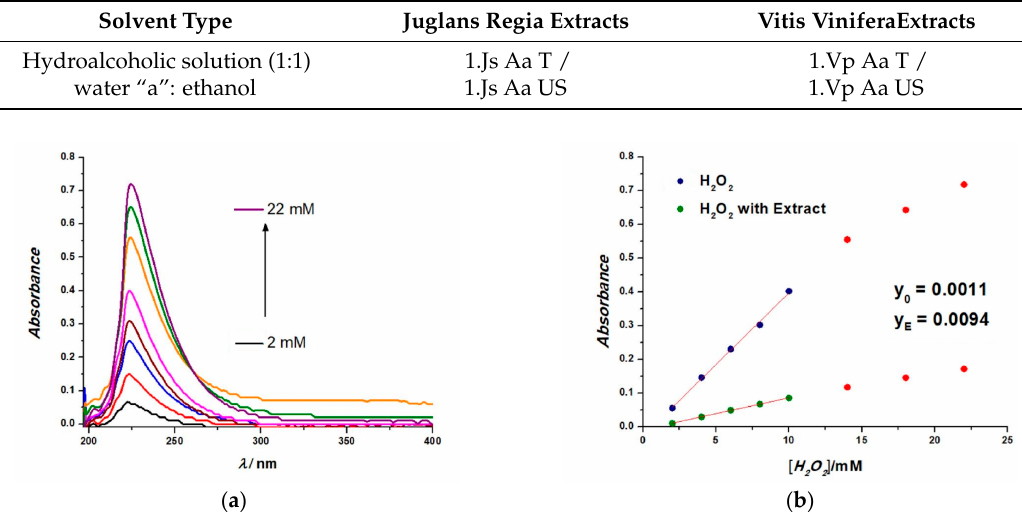
Table 2. List of used hydroalcoholic plant extracts with corresponding extraction method used in spectrophotometry in addition to the extracts in Table 1. Solvent Type Hydroalcoholic solution (1:1)